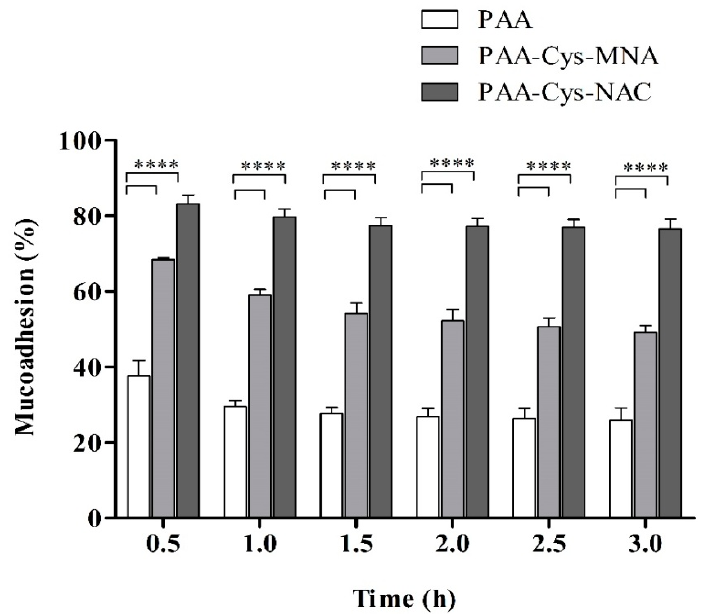
Figure 11. Percentage of remaining unmodified PAA and S-protected thiolated PAA on porcine intestinal mucosa continuously rinsed with 50 mM phosphate buffer pH 6.8 at 37 °C and 100% relative humidity at indicated time points. The data are shown as mean ± SD (n = 3).